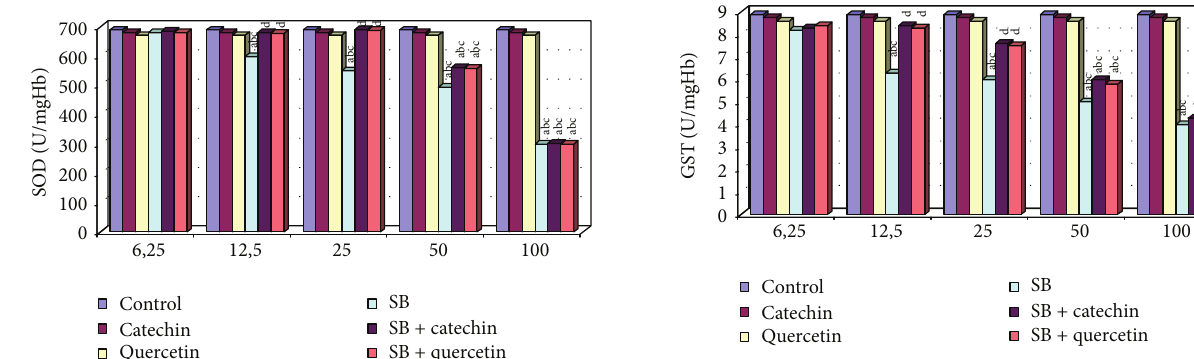
Figure 2: SOD activity in erytrocytes of control and experimental groups. Different letters above the bars indicate significant differ- ences between exposure concentrations; bars with the same letter are not significantly different. Values are mean ± SD in each group. Significance at 𝑃 < 0.05 .